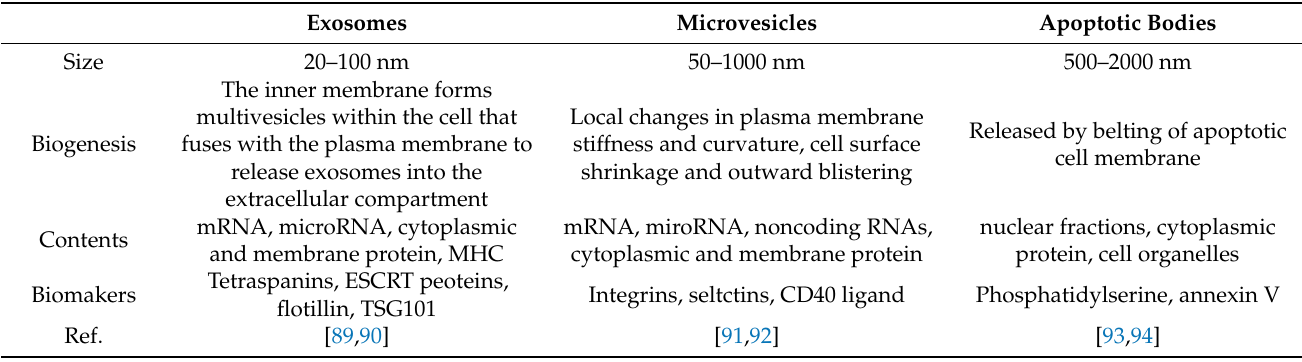
Table 2. Classification of different types of extracellular